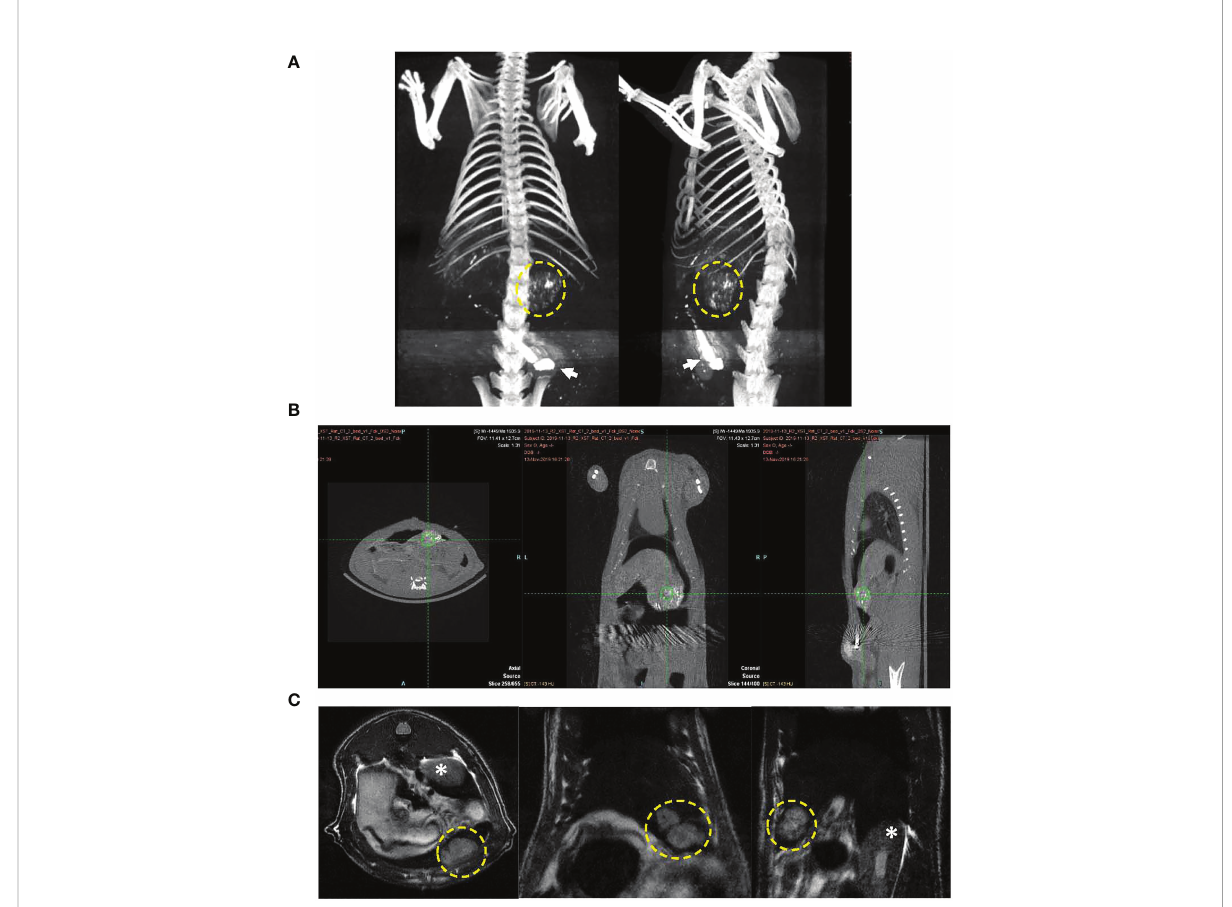
FIGURE 3 CT image of port-catheter system in the N1S1 tumor bearing rat. CT scan of the rat abdomen with three-dimensional reconstructed coronal image. The port system is fi lled with contrast material (Ethiodized oil) for visualization of the port (arrow) and the catheter line feeding into the gastroduodenal artery. Contrast material was also administered into the animal, some aspects of the liver ’ s contour, hepatic vasculature and tumor (dashed yellow circle) can be seen. (B) CT images in three planes showing soft tissue anatomy of tumor bearing rat. Accumulation of contrast material can be seen in the tumor (green hatch marks). (C) Multiplane T2 weighted MRI of N1S1 tumor bearing rat. Tumors appear hyper intense on images (dashed yellow circle). * indicates